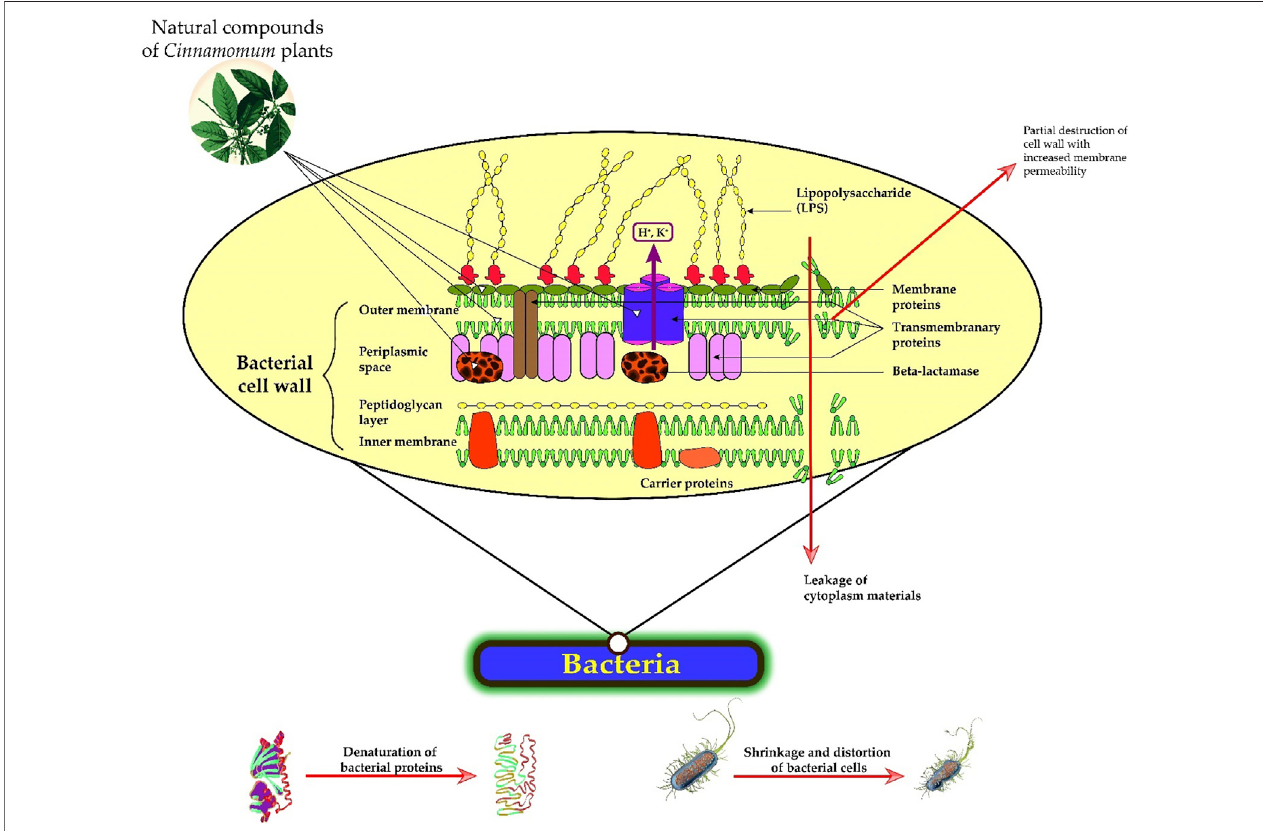
FIGURE 2 | Antibacterial properties of Cinnamomum plants ’ derivatives. The main potential mechanisms of antibacterial action are related to: 1) the partial degradation of the bacterial cell wall, 2) the increase of membrane permeability, 3) the leakage of cytoplasm materials, 4) the shrinkage of bacterial cells and prominent distortion, and 5) the alteration of secondary, tertiary structures and bacterial